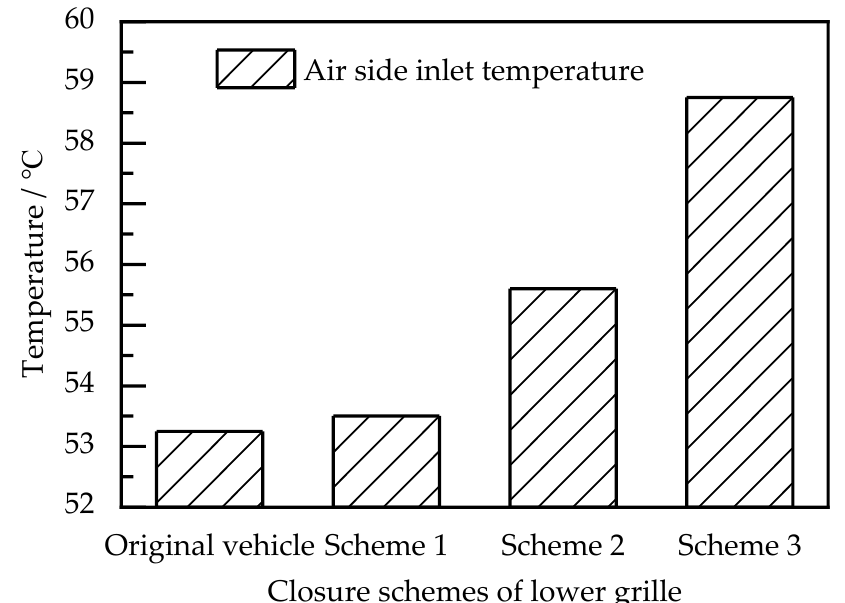
Figure 22. Velocity fields of z = 0.08 m section under different lower grille closure schemes: ( a ) original vehicle; ( b ) scheme 1; ( c ) scheme 2; ( d ) scheme 3.